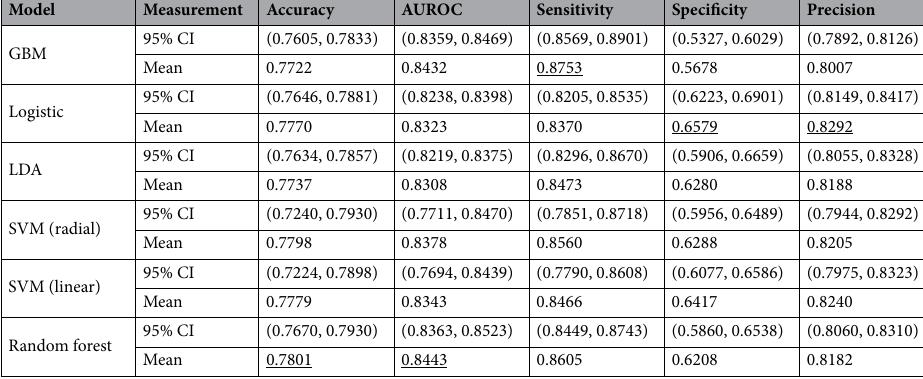
Table 3. The summary statistics of model performance calculated by bootstrap. The empirical 95% confidence intervals and means of five measurements were calculated for each model. The highest mean values among the six models are